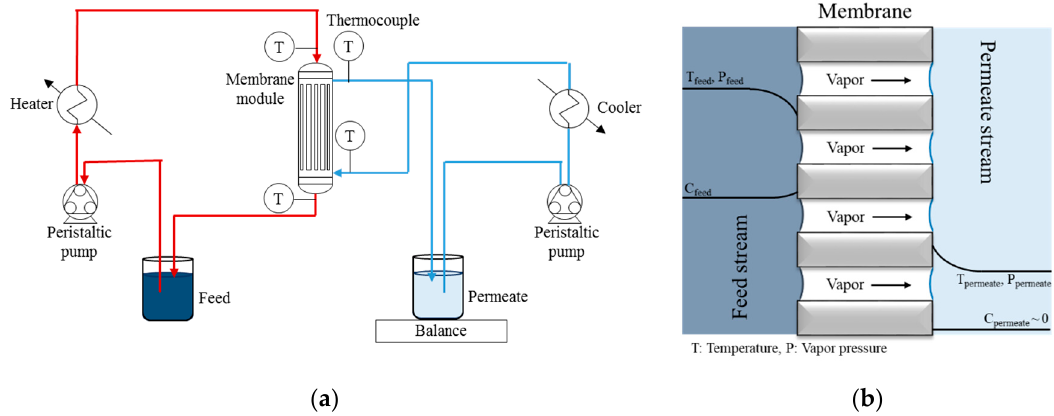
Figure 1. ( a ) Scheme of a typical direct contact membrane distillation (MD) apparatus and ( b ) cross-sectional diagram of a MD action: vapour pressure (p) temperature (T), and concentration of solutes (C) at the feed and the permeate side.